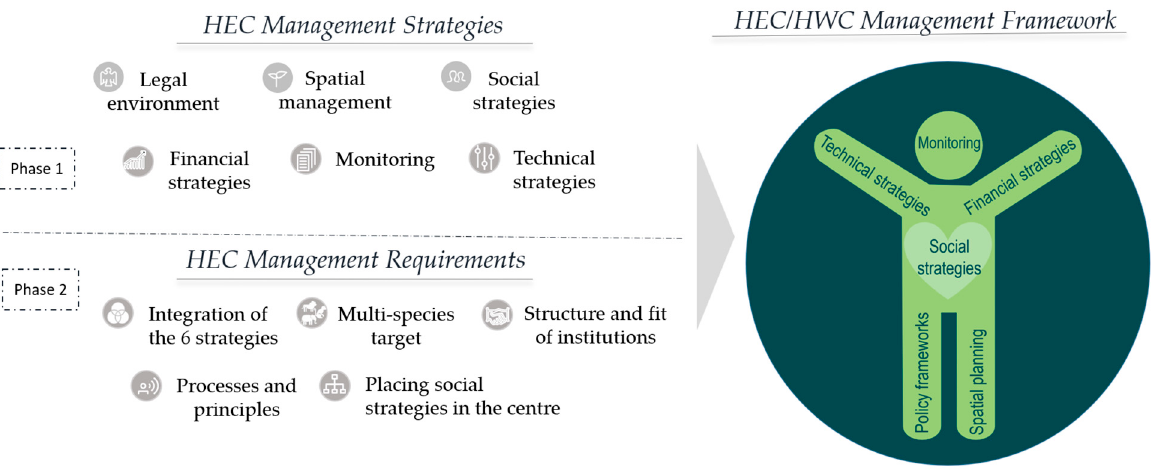
Figure 3. Illustration of the integration of phase 1 and phase 2 results into the HEC/HWC-management framework.